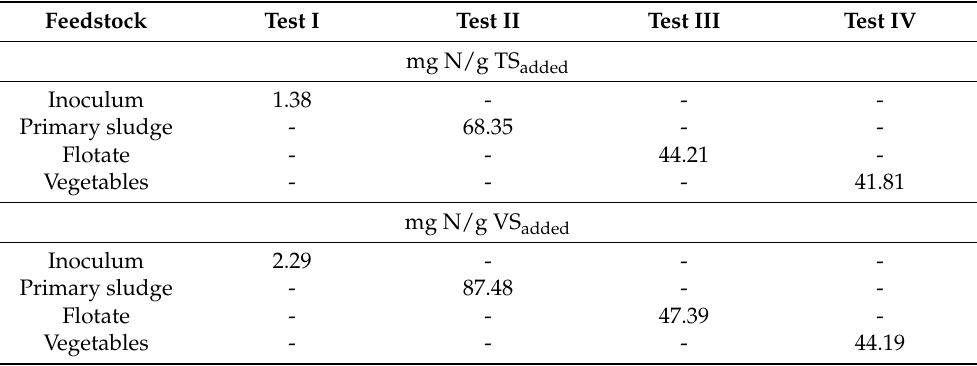
Table 6. Unit value of total nitrogen release rate to the liquid fraction during methane fermentation (T = 36 ◦ C, HRT = 29